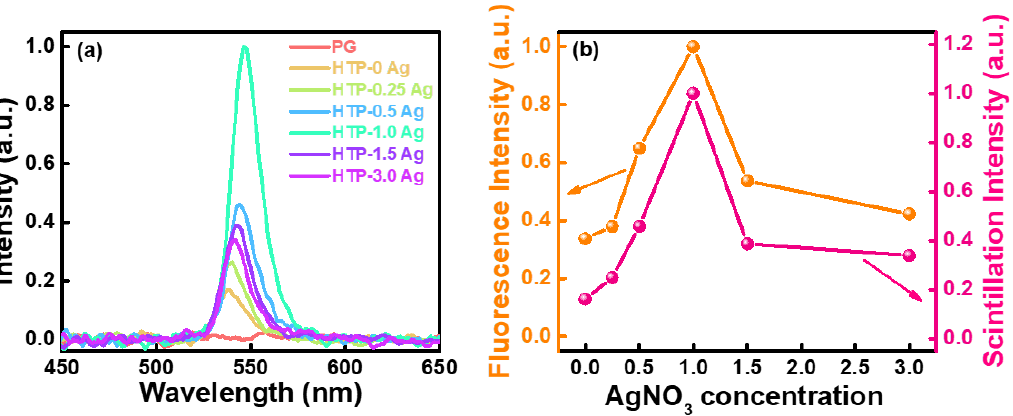
Table 1. Scintillation performances of CsPbBr 3 QD-doped glasses containing Ag NPs.